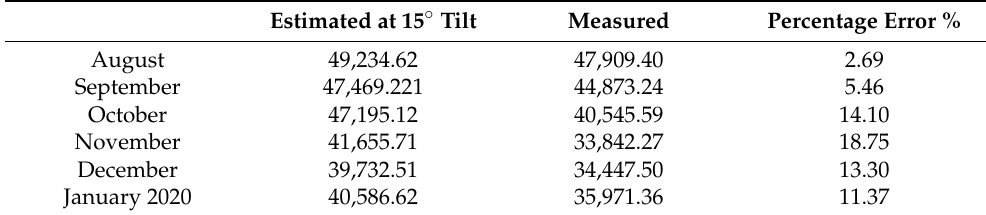
Table 6. Comparison between estimated and measured energy output of the PV system in kWh, with percentage error